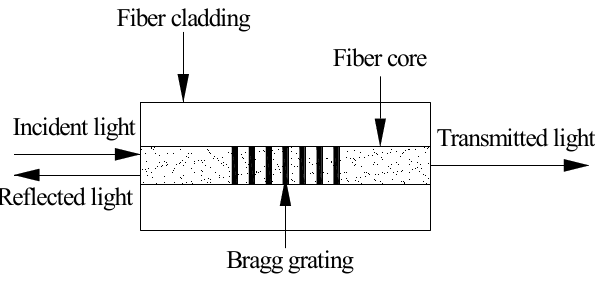
Figure 2. Schematic of FBG sensor technology.